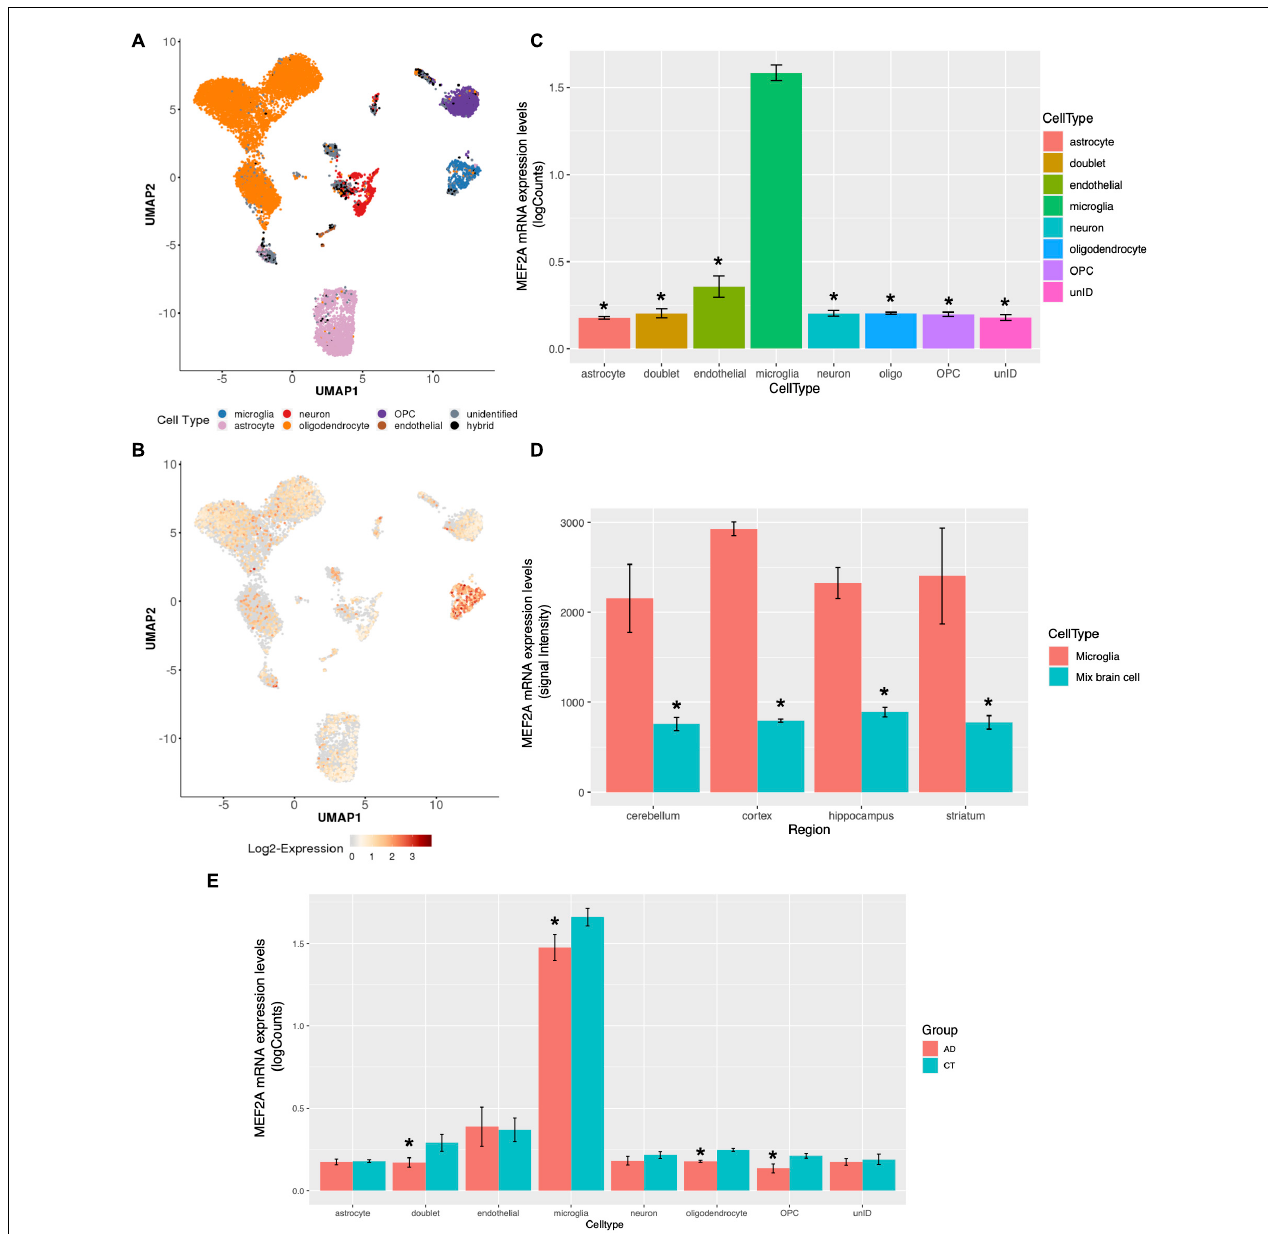
FIGURE 5 | MEF2A expression in brain tissue for different cell types. The snRNA-seq data of GSE138852 (Grubman et al., 2019) were downloaded, and the expression of MEF2A in different cell types were analyzed (A, B, C, E). (A) The PCA analysis for cells with different types of markers and cells were clearly divided into eight clusters. (B) The differential mRNA expression of MEF2A in each cell types are shown, and the red color indicates high expression. (C) The mRNA expression of MEF2A in different cell types was performed using GraphPad. An ANOVA followed by an LSD test were used for comparison among groups. * p < 0.05 compared with the microglia group. (D) The mRNA expression of MEF2A in microglia and in mixed brain cell from different brain regions in dataset GSE62420 (Grabert et al., 2016) were performed using GraphPad. An ANOVA followed by an LSD test was used for comparison among groups. * p < 0.05 compared with the microglia group. (E) The mRNA expression levels of MEF2A in AD and in healthy controls are shown. t -Test was performed for comparison between groups. * p < 0.05 compared with the control group.